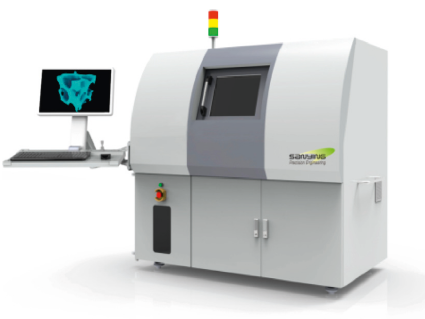
Figure 2: Picture of the nanoVoxel-2000 series X-ray 3D microscope.